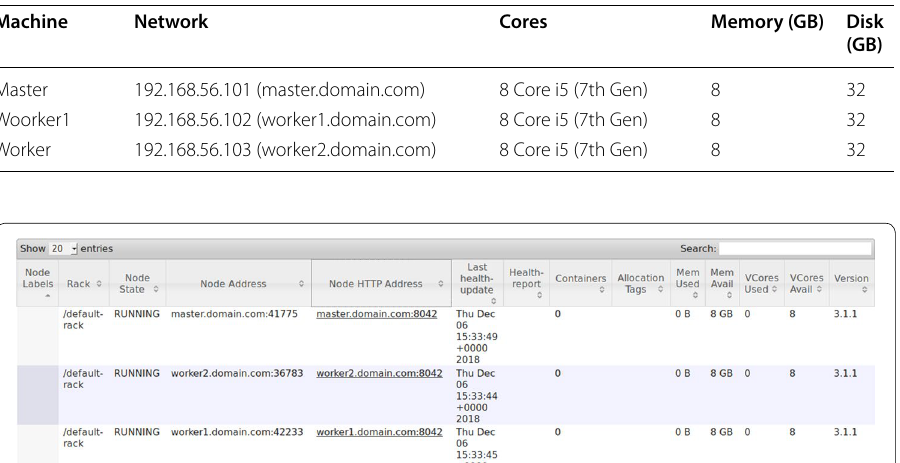
Table 1 Cluster nodes configuration